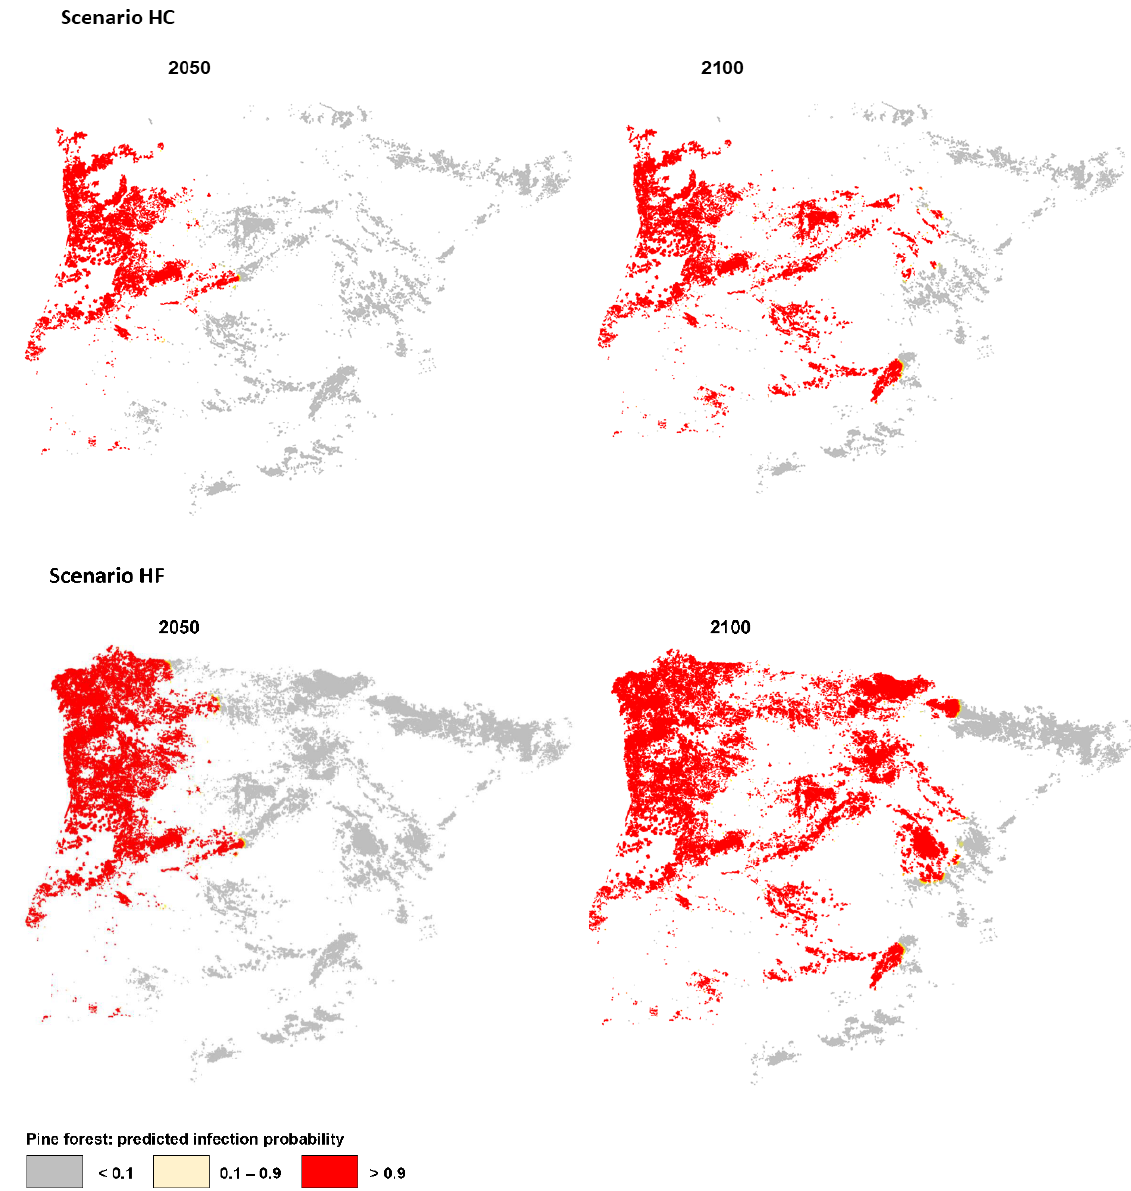
Figure 2. PWN spread in the Iberian Peninsula for the years 2050 and 2100, considering only the forests composed by pine tree species with high susceptibility to infection. Both the current climate (Scenario HC) and future climate (Scenario HF) are considered.